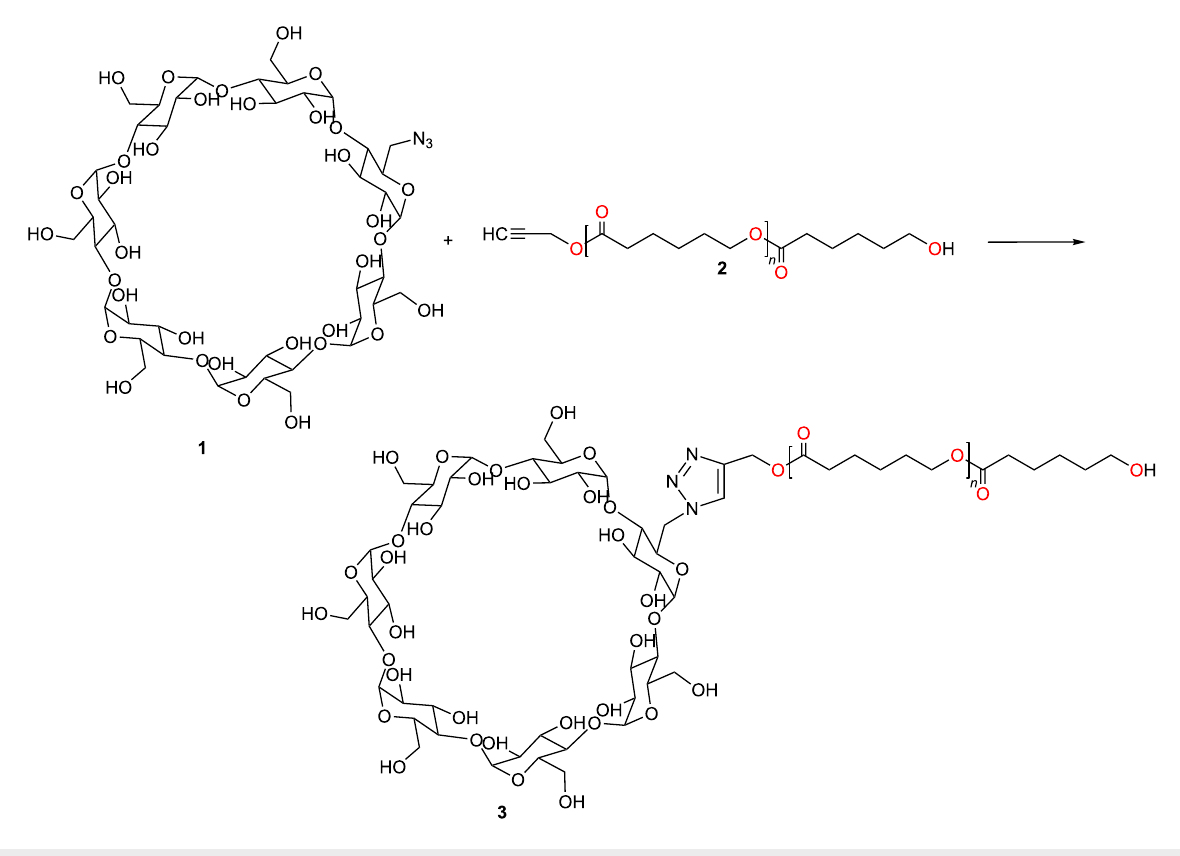
of the nanoparticles encapsulating umbelliferone was bigger than the diameter of the nanoparticles without